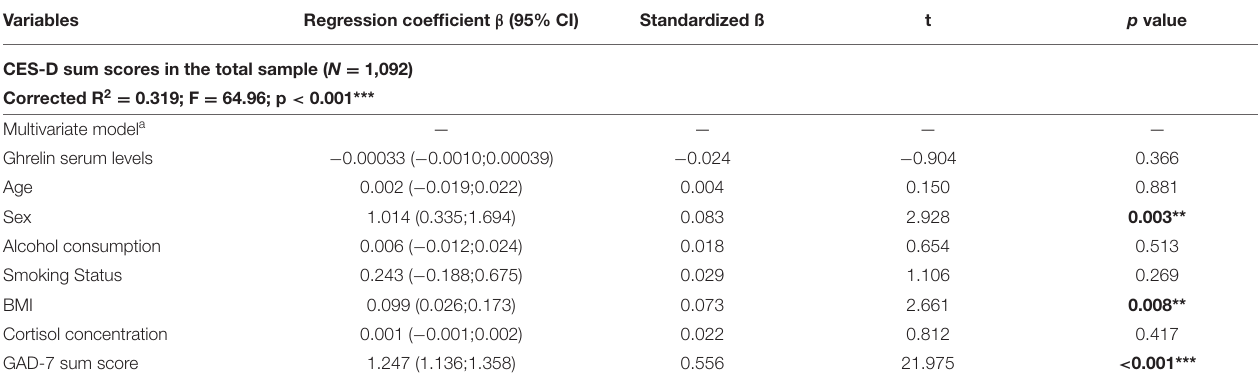
TABLE 2 | Results of multiple linear regression analyses regarding the association between ghrelin serum levels and CES-D sum scores reflecting the intensity of depressive symptoms in participants of the study.